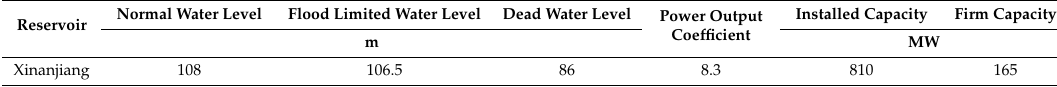
Table 2. The characteristic parameters of the Xinanjiang hydropower